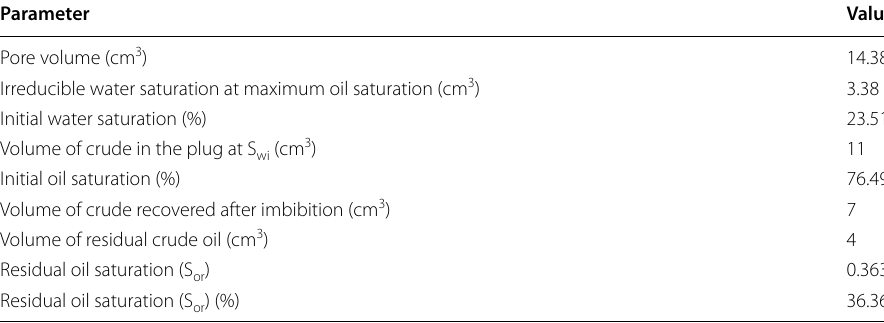
Table 6 Initial water saturation and residual oil saturation